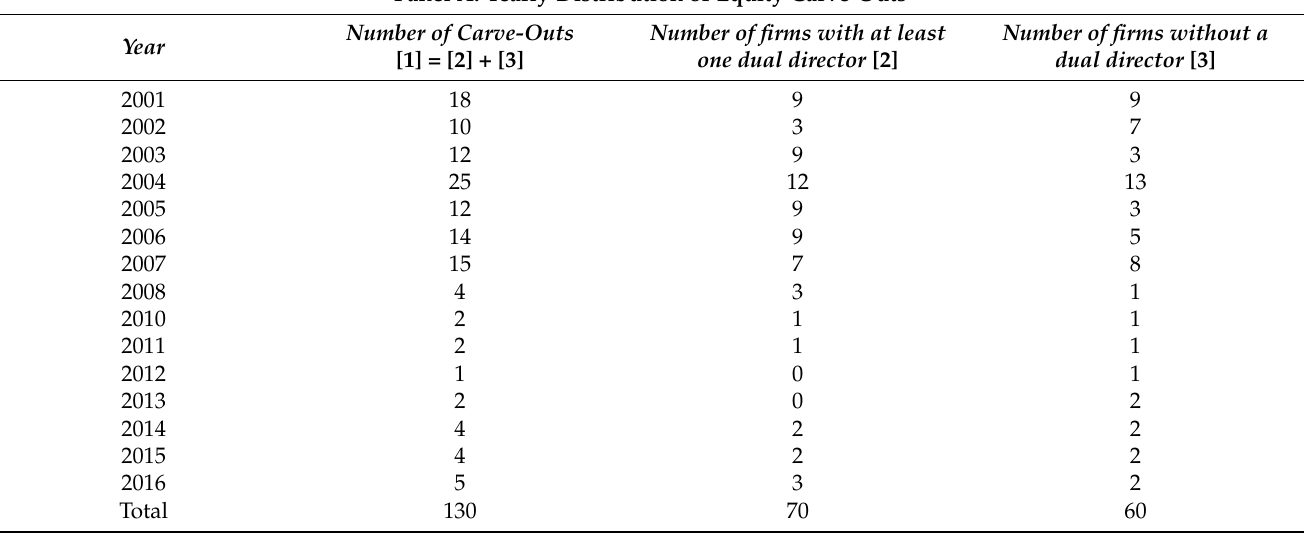
Table 1. Descriptive statistics for equity carve-outs. Panel A reports the annual frequency of equity carve-outs during the period 2001 through 2016. Panel B reports the industry distribution. Panel C reports the percentage of ownership of the subsidiary by the parent company. Panel A: Yearly Distribution of Equity